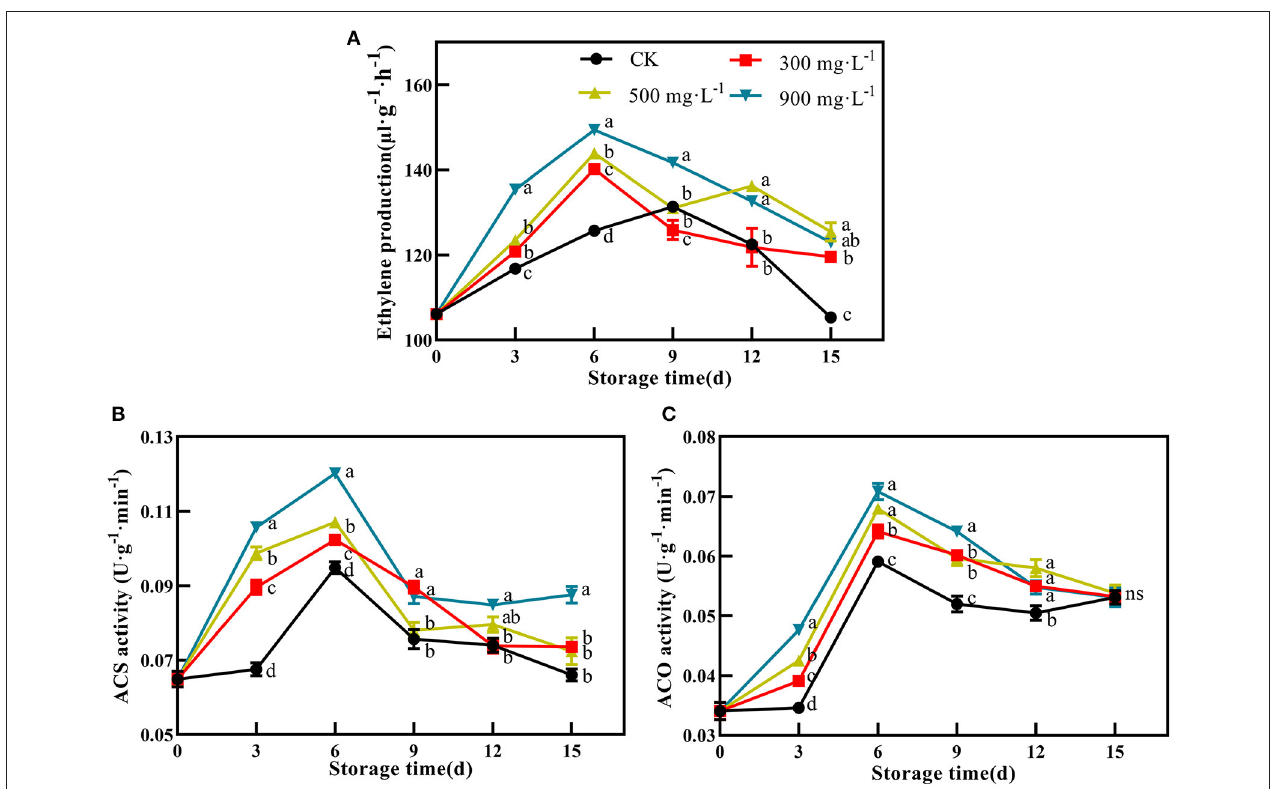
FIGURE 3 | Effects of ETH treatment on production of endogenous ethylene (A) and activities of ACS (B) and ACO (C) . Values followed by different letters are significantly different based on Duncan’s multiple range tests at P < 0.05. The error bars indicate the standard deviations of three biological